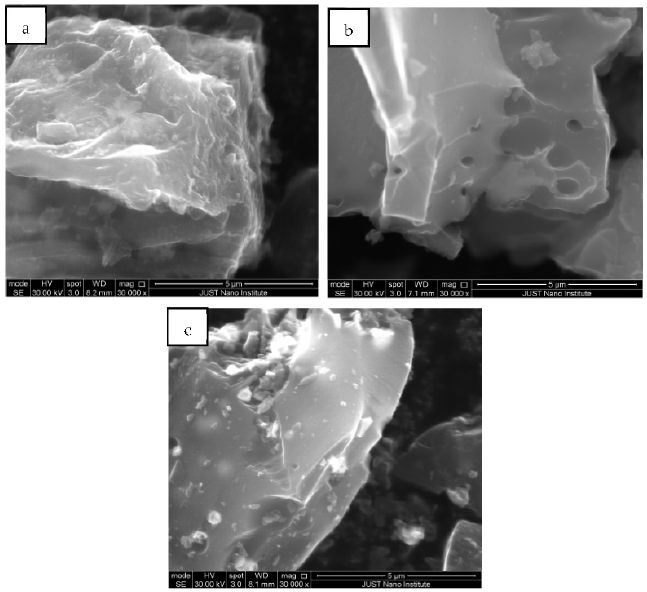
Figure 2. SEM images for ( a ) parent AC, ( b ) Ox-AC, and ( c ) Ox-AC/Cu/Cu 2 O/CuO. Table 1. EDS analysis for parent AC, Ox-AC, Ox-AC/Cu/Cu 2 O/CuO.